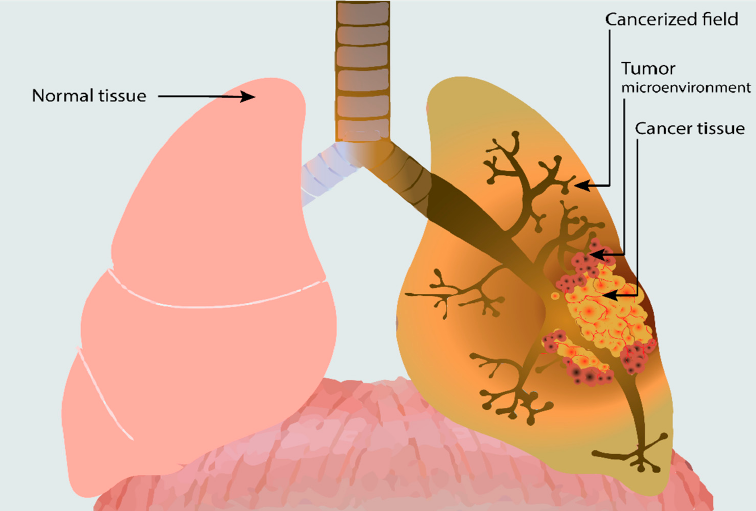
Figure 1. Lung cancer and its associated tumor microenvironment and extensive field cancerizations. We can notice the local spread of the tumor microenvironment (TME) surrounding the tumor, consisting of various cellular populations (lymphocytes, neutrophils, macrophages, dendritic cells, fibroblasts, etc.). Adjacent to the TME, the cancerized field is associated with lung cancer, which diffusely extends upwards in the respiratory tract. The cancerized field can present various histologic changes, from hyperplasia to metaplasia and high-grade dysplasia, or might appear histologically normal, bearing only some focal genetic